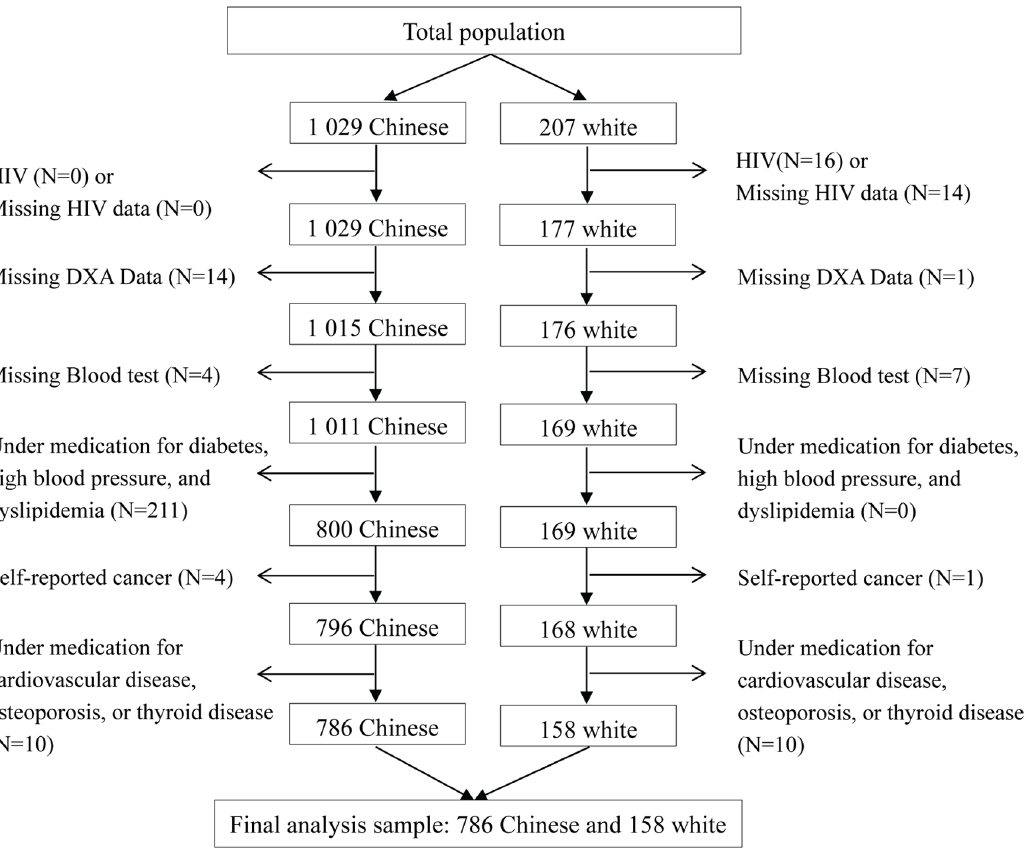
Figure 1. Flowchart of participant selection. DXA, dual-energy X-ray absorptiometry.